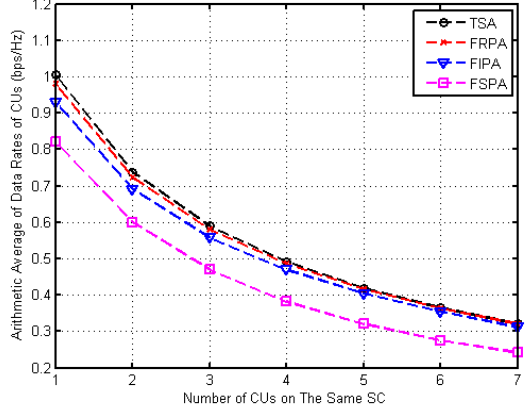
Figure 9. Arithmetic average of data rates versus number of CUs on the same SC. We study how the increasing of users influences the arithmetic average of the data rates on each SC where the number of the users changes from 1 to 7.